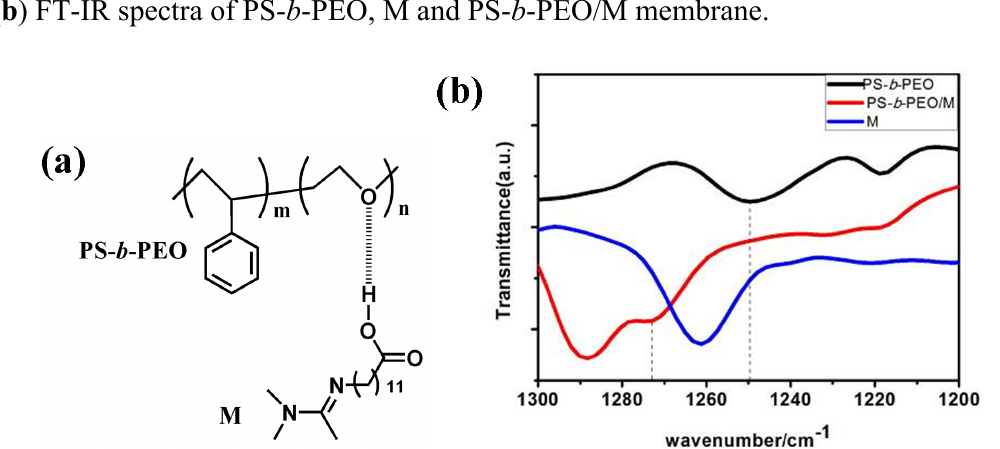
Figure 1. ( a ) The chemical molecular structure of the PS- b -PEO and guest molecule M; and ( b ) FT-IR spectra of PS- b -PEO, M and PS- b -PEO/M